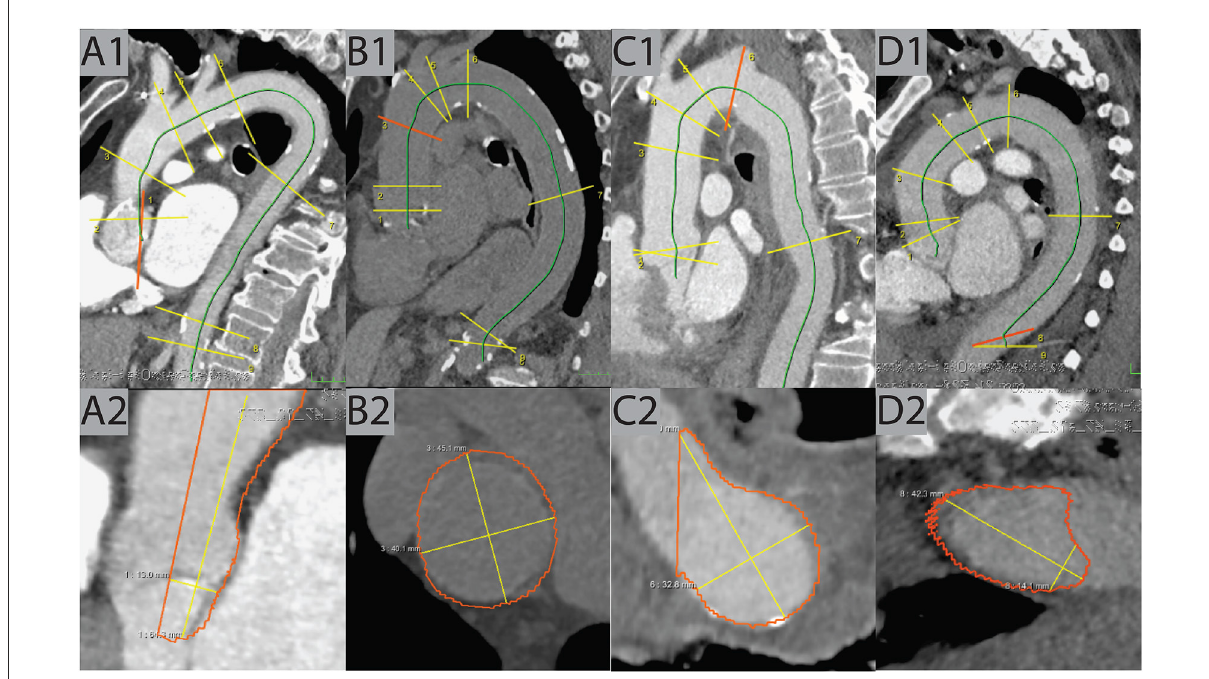
FIGURE4 Examples of false positive cases. (A) Due to an error in centerline placement, the AS plane was tilted and falsely contoured, resulting in a false-high measurement in this pulmonary-arterial scan of a 93-year-old female patient. (B) In this non-CE scan of an 82-year-old female patient, the contouring at the AA location was too wide, resulting in a false-high measurement. (C) The CT in pulmonary-arterial phase of 75-year-old male patient showed an aberrant right subclavian arteria. This caused an error contouring the location of the DA, resulting in a false-high measurement. (D) The last two locations (DDA, ABA) in the pulmonary-arterial phase CT of an 85-year-old female patient were tilted caused by an erroneous centerline placement, resulting in a false-high measurement at DDA (42mm). AA, ascending aorta; ABA, abdominal aorta; AS, aortic sinus; CE, contrast enhanced; DA, distal arch; DDA, distal descending aorta.